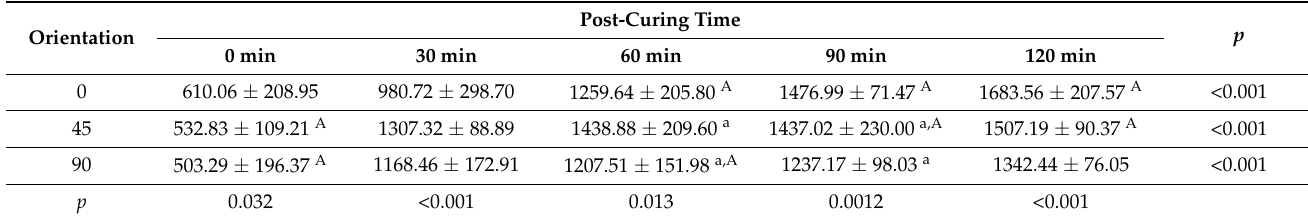
Table 3. Fracture load (N) across the different tested groups for NextDent resin.